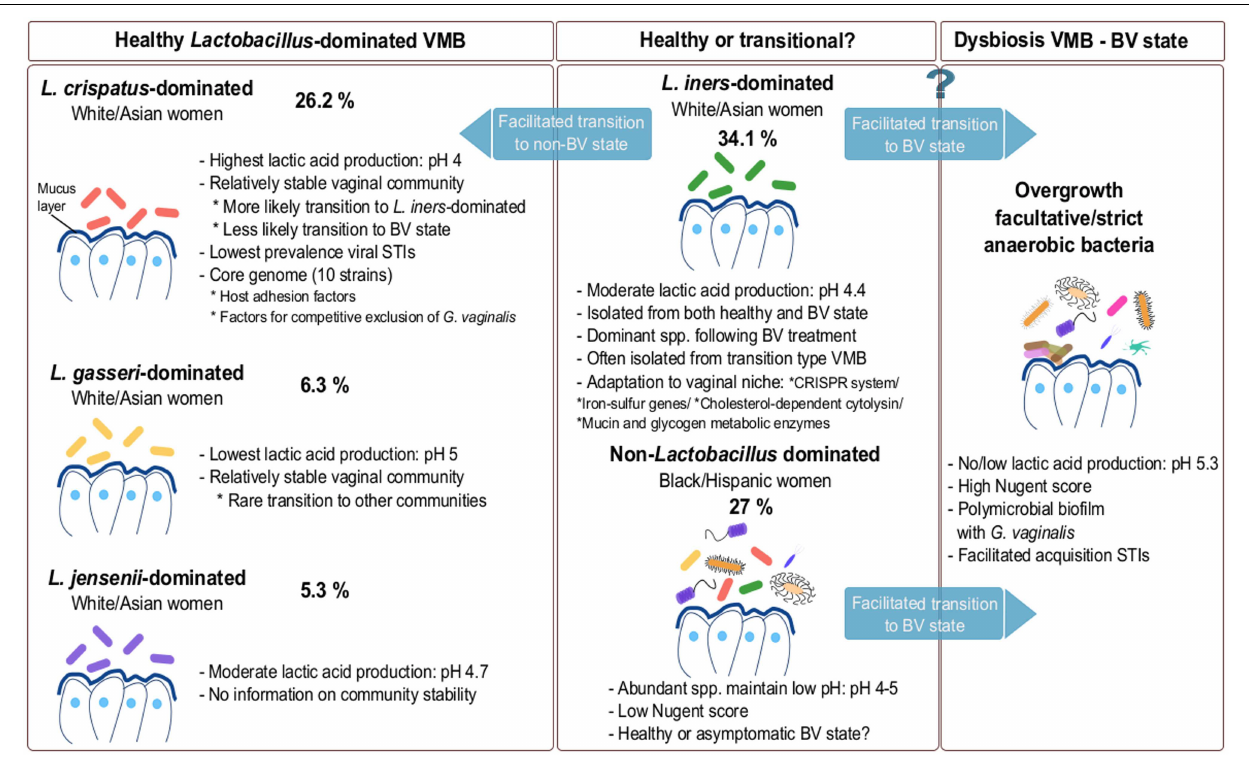
FIGURE 1 | Composition of VMB during healthy and dysbiotic states. The vaginal microbiota in healthy adult premenopausal women can be divided into different community groups. The exact number and type of community groups is still under debate (Verhelst et al., 2005; Ravel et al., 2011; Gajer et al., 2012; Santiago et al., 2012 ). The most commonly isolated dominating species belong to L. crispatus , L. gasseri , L. iners and L. jensenii . The vaginal community group dominated by L. iners is also often isolated during menstruation and in the transitional microbiota between healthy and BV state or vice-versa.